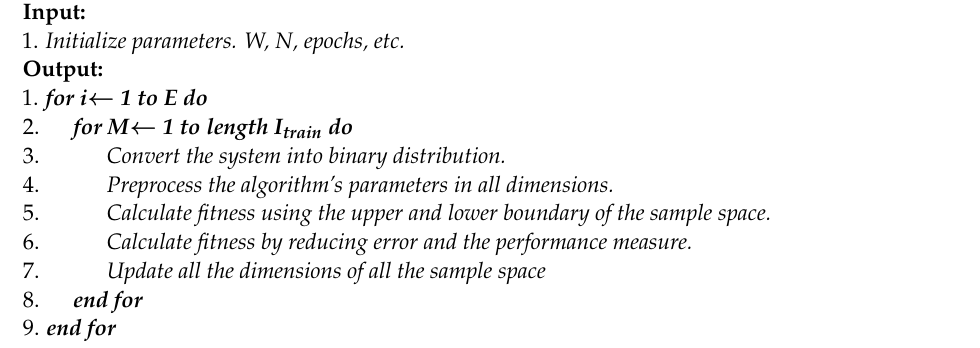
Algorithm 2. Optimization